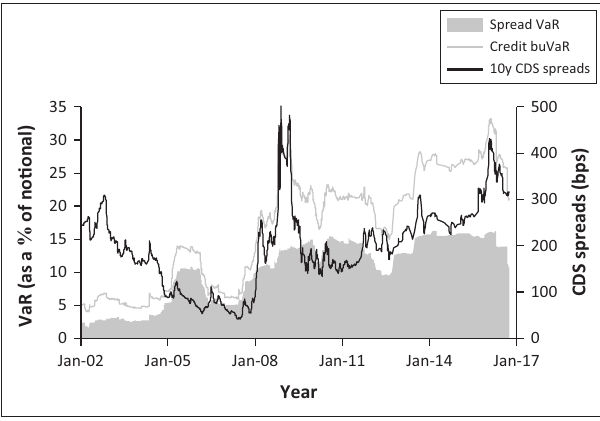
FIGURE 6: Credit buVaR for 10-year credit default swap spreads (risk-free rate = 7.00 % , bond recovery rate = 50 % , ω